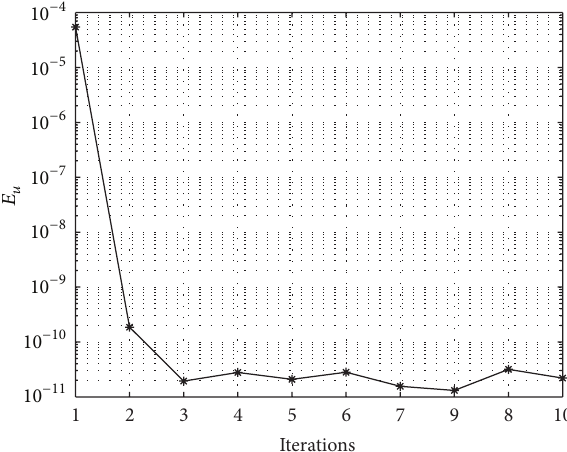
Figure 13: Fishers equation convergence graph.